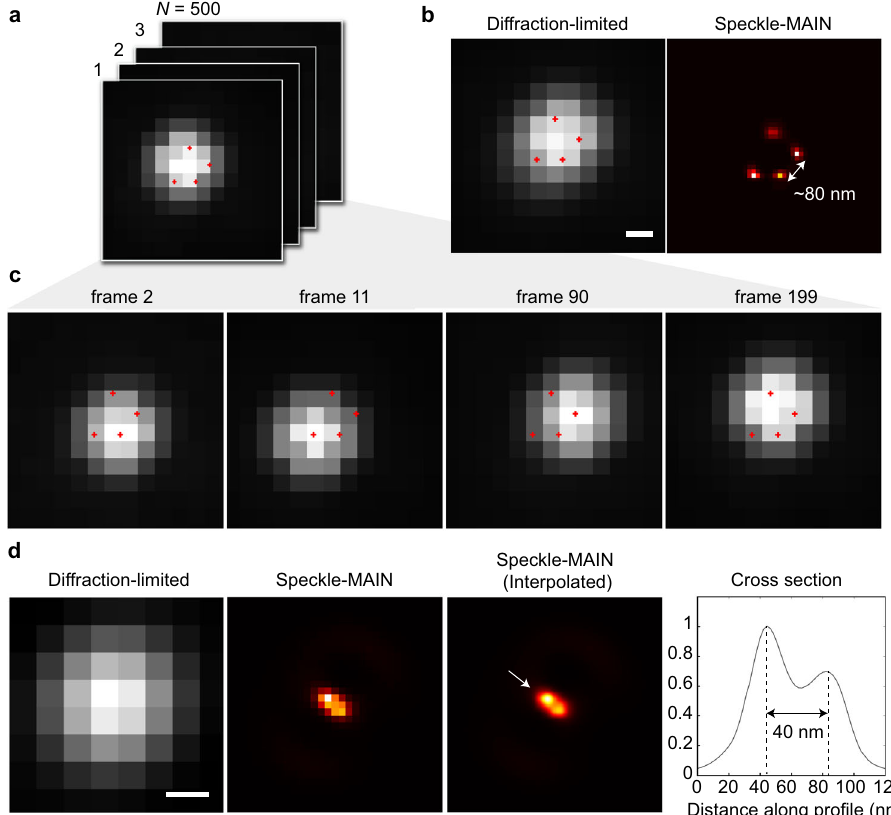
Fig. 3 Super resolution speckle-MAIN demonstration. a An intensity normalized image stack of fl uorescent beads on HMM-coated substrate with different illumination condition. Objective lens: Olympus 100×/1.5 oil. Frame rate: 1 Hz. Exposure time: 500 ms. Total frame: 500. b Diffraction-limited image and the reconstructed speckle-MAIN image. The speckle-MAIN image is reconstructed from 500 diffraction-limited frames. Pixel size: diffraction- limited, 65 nm; speckle-MAIN, 22 nm. Locations of the reconstructed beads are marked in those raw frames. The diffraction-limited image is computed by averaging all 500 frames. Scale Bar: 100 nm. c Four selected frames indicate a sub-diffraction changes of illumination pattern. d Imaging of two close fl uorescent beads shows speckle-MAIN resolution down to ~40 nm. The cross section is plotted along the arrow direction in the interpolated speckle- MAIN image. Speckle-MAIN (interpolated) has 10 times interpolation from speckle-MAIN image. Pixel size: diffraction-limited, 65 nm; speckle-MAIN, 16 nm. Scale bar: 100 fi eld. We use 200 ms exposure time and 1 Hz frame rate to wait for the multimode fi ber to stabilize in Fig. 5. The fl uorescent signal is collected by an objective lens (40× /0.6 NA Olympus objective) with proper emission fi lter (520/40 nm band-pass fi l- ter). A set of 200 frames are used for image reconstruction.